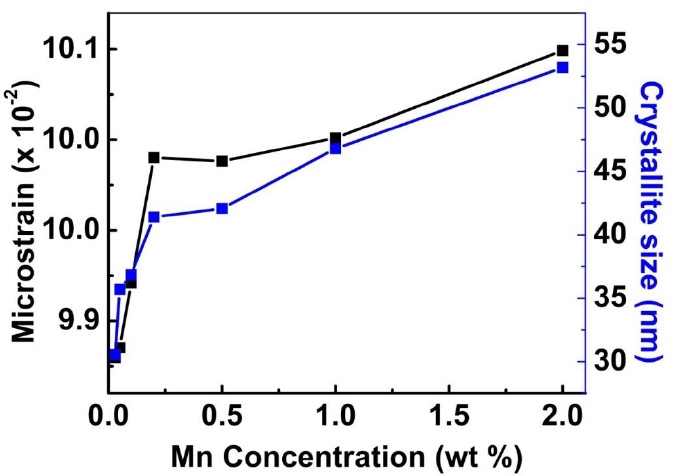
Figure 4. Comparative strain (black square) and crystallite size (blue square) of Zn 2 SiO 4 as a function of Mn doping in Zn 2 SiO 4 host lattice.